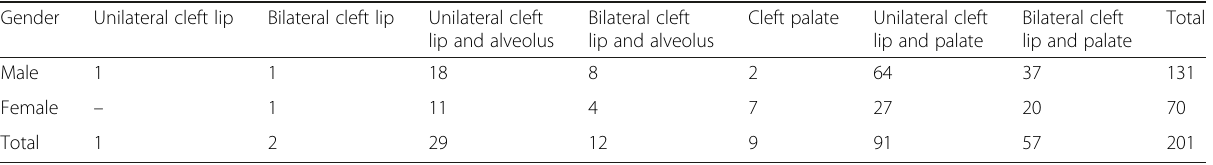
Table 2 Distribution of samples according to cleft